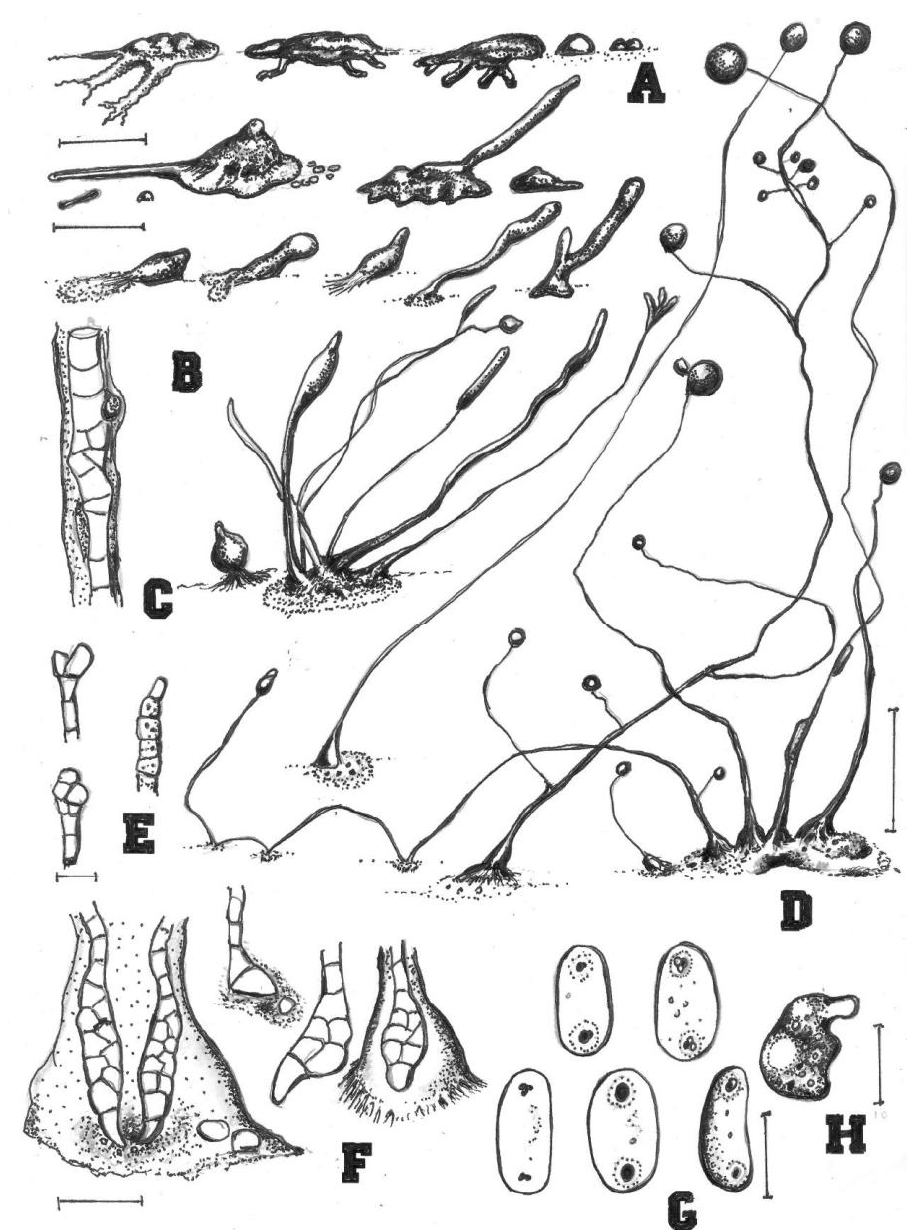
Figure 8. Morphological features of Cavenderia ungulata (TH18B). ( A ), Small to medium aggregations with short thick streams (left, center) and irregular small mounds (right). ( B ), An early sorogen rises up from the center, one elongated pseudoplasmodium stream remains (above, left); one early-late sorogen emerges from the side of the mound (above, right); from left to right: solitary migrating early sorogens (center); a cluster of late sorogens (below, right). ( C ), Irregular segment of a sorophore. ( D ), Solitary unbranched mature sorocarp with mucilage rest at the base (left); curved sorocarp with some branches (center); clustered sorocarps with ascending masses of small pseudoplasmodia, on the left margin there is a stoloniferous habit that progress to the left (right). ( E ), Two types of capitates tips (left); a flexuous simple tip (right). ( F ), Two tightly clustered clavate bases with terminal cells as cat claws, the darken matrix of slime is very dense and with large granules of yellow pigment (left); two solitary bases with enlarged terminal cells (center); a clavate regular base with its basal slime and sheath (right). ( G ), Slightly large elliptical spores with protruding PG (regular in shape) generally of the same size in both poles, also with vacuoles and halos. ( H ), Myxamoeba with many small-medium vacuoles. Bars: ( A ) = 300 μ m; ( B ) = 200 μ m; ( C – E ) = 15 μ m; ( D ) = 0.5 mm; ( F ) = 20 μ m; ( G ) = 6 μ m; ( H ) = 10 μ m.